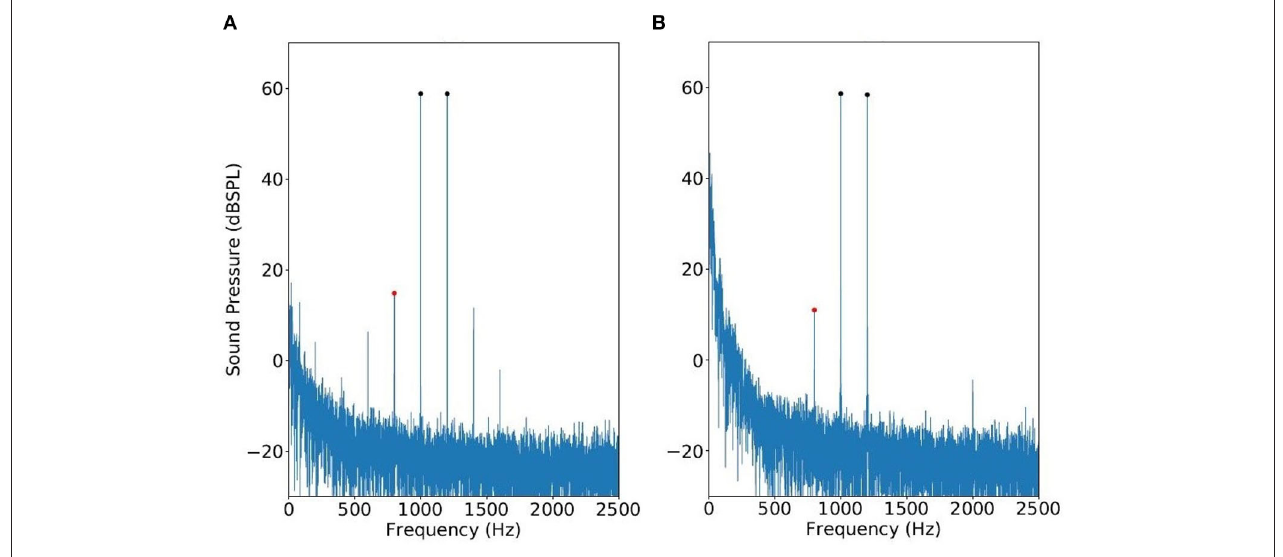
FIGURE 1 | Spectrums of modulation distortion produced by a single speaker (A) vs. true DPOAE obtained with a two-speaker probe (B) . The primary frequencies are f 1 = 1,000 Hz and f 2 =